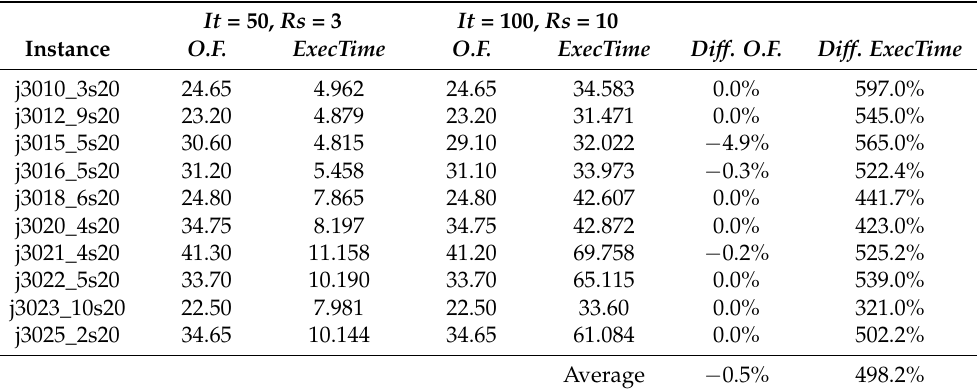
Table 5. Results of the pre-experiment for instances with 30 activities.